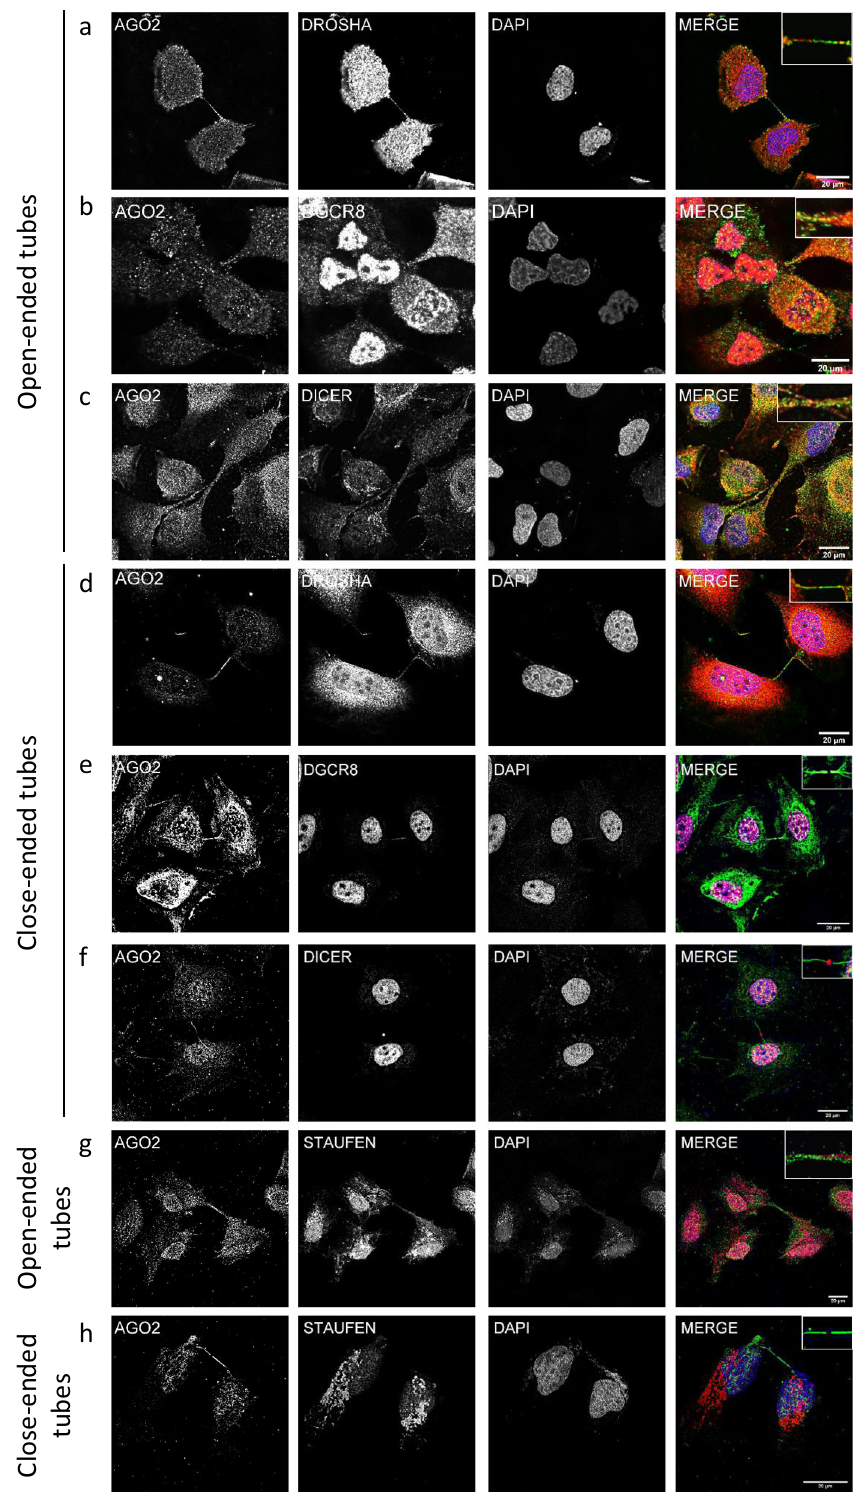
Fig. 2 AGO2 resides in protrusional structures along with other components of the RNAi-machinery. Representative immuno fl uorescence images of NTHY ori 3-1 cells of a , b , c , g AGO2 open-ended tunneling nanotubes and d , e , f , h close-ended cellular protrusions with a , d Drosha, b , e Dgcr8, c , f Dicer, and g , h Staufen. AGO2 was visualized in green, Drosha, Dgcr8, and Dicer in red, and nuclei in blue (DAPI). The scale bar is 20 μ